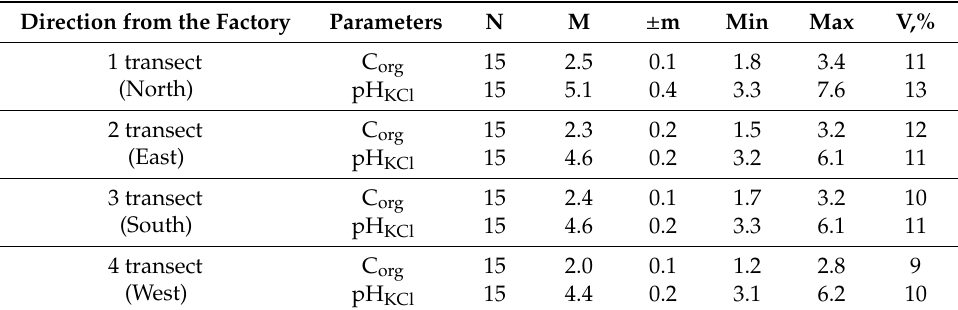
Table 4. Statistical parameters of the physical and chemical properties of the upper soil horizons (0–10 cm) of the industrial zone in the area of OAO “Gubakhinsky coke” ( p = 0.05). Direction from the